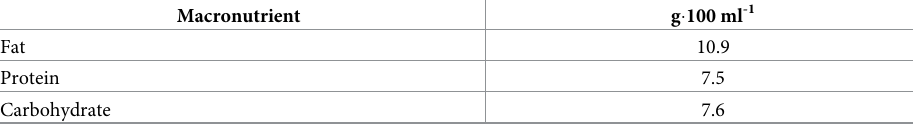
Table 1. Composition of macronutrients in artificial